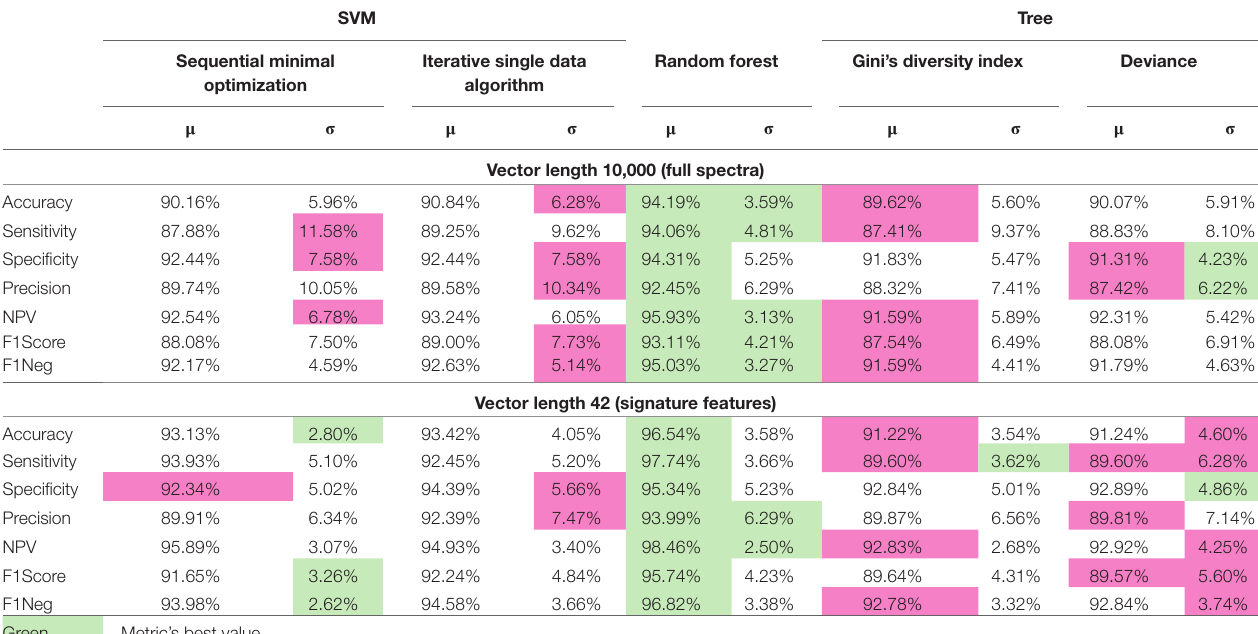
TaBle 4 | Comparison of 10-round training and validation results between classifiers using same datasets for the full-length input vectors and for the signature features selected by the reduction method proposed in the article. sVM Tree sequential minimal iterative single data random forest optimization algorithm